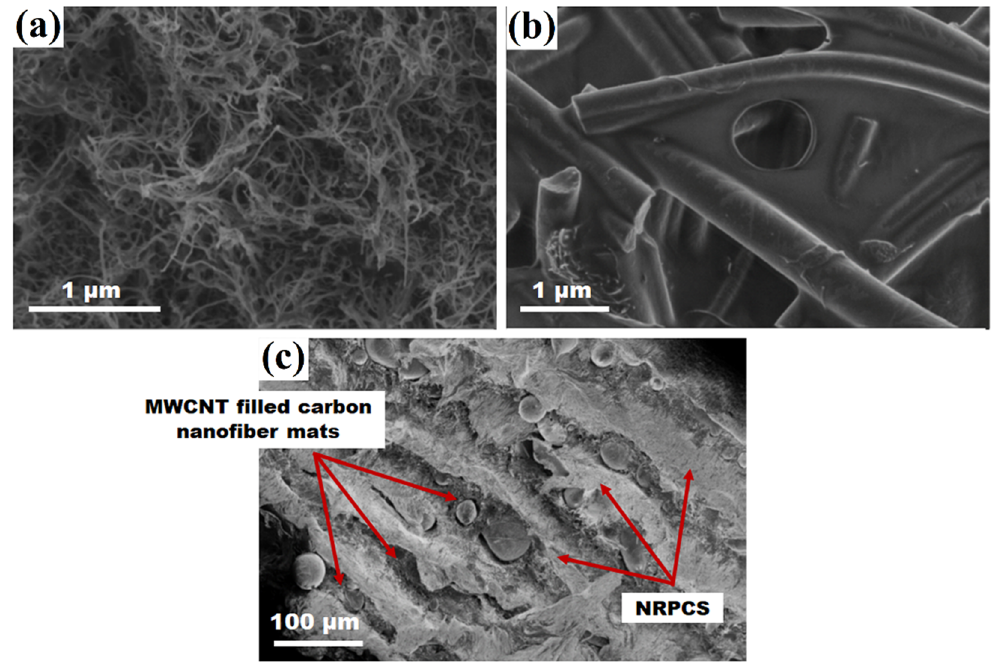
Figure 5. SEM images of ( a ) a cross-sectional of the NRPCS; ( b ) MWCNT filled carbon nanofiber mat embedded within the NRPCS; and, ( c ) the cross-sectional area of an eight-layered flexible composite.